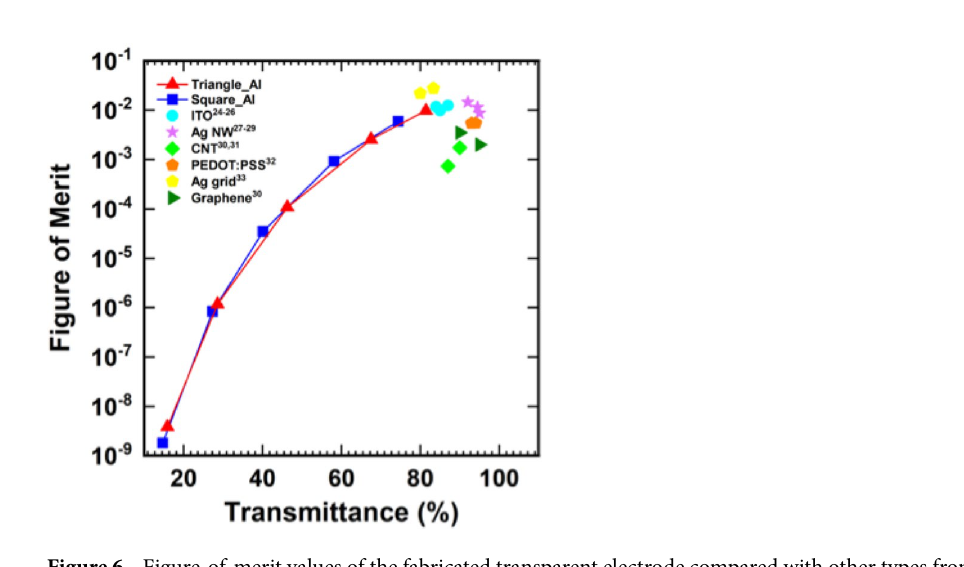
Figure 6. Figure-of-merit values of the fabricated transparent electrode compared with other types from the literature (ITO 25,26 , Ag NW 28–30 , CNT 31,32 , PEDOT:PSS 33 , Ag grid 34 , Graphene 31 ) for